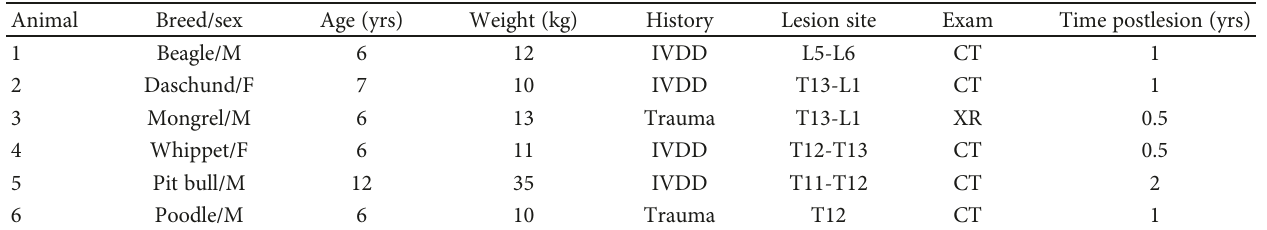
Table 1: Summary of clinical data of dogs with SCI transplanted with allogeneic adipose tissue-derived mesenchymal stem cells. Animal